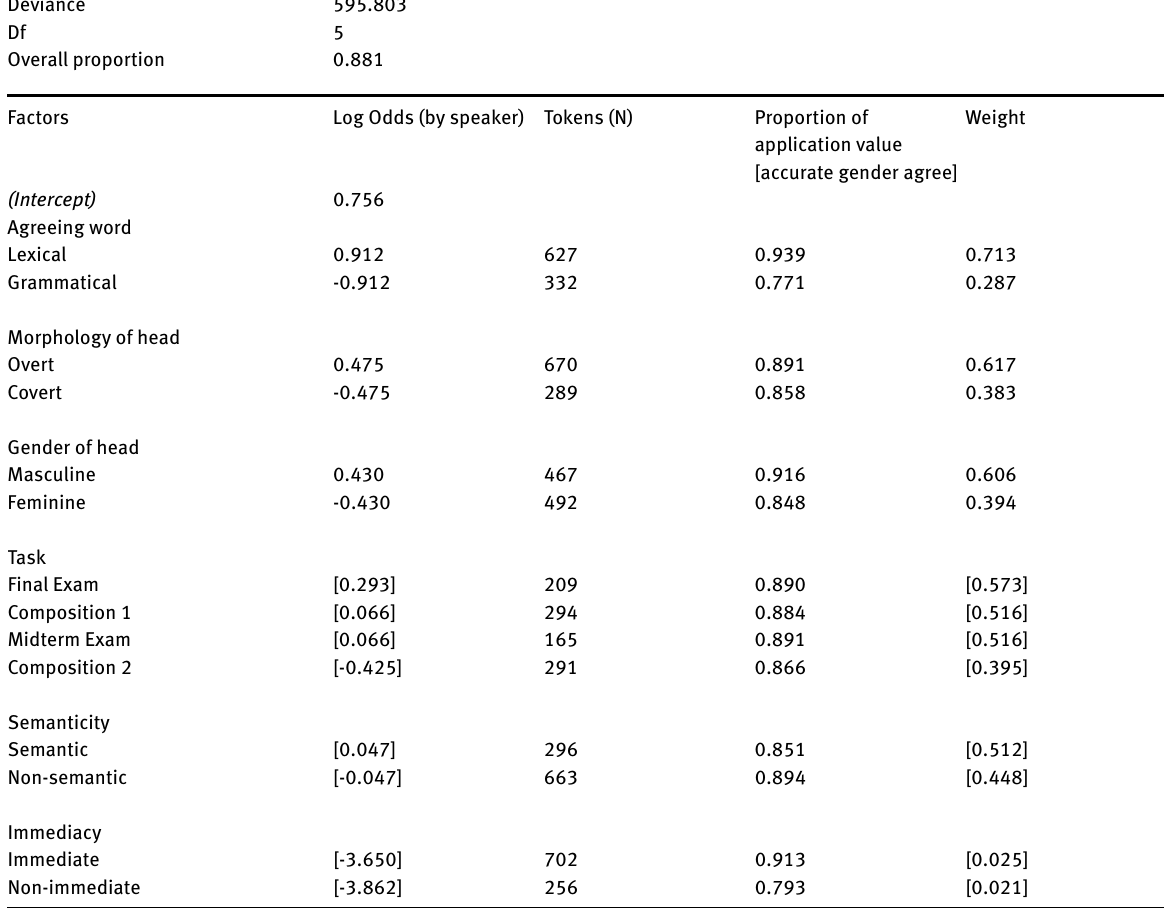
Table 4. Accurate versus inaccurate gender agreement in Beginning 1 online